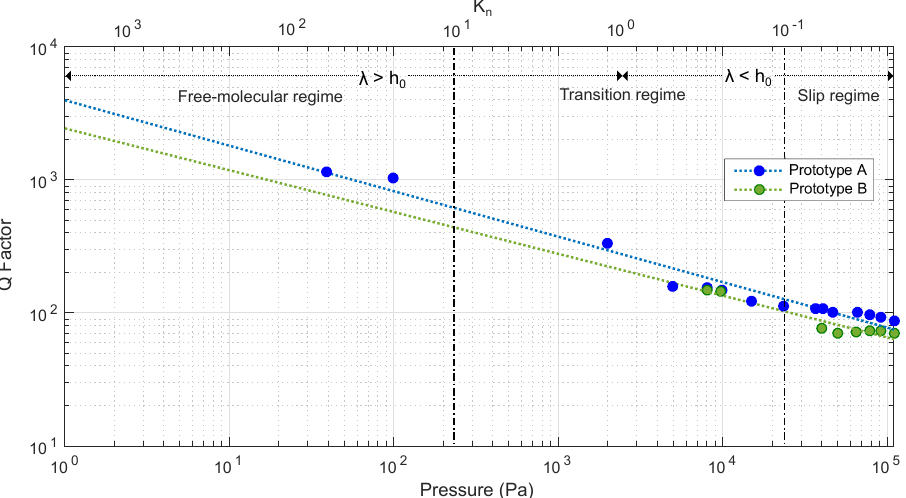
Figure 7. Q-factor experimental measurements against pressure, and fitting by linear regression for each prototype. Regimes based on K n at a constant room temperature of 23 ◦ C are also shown.